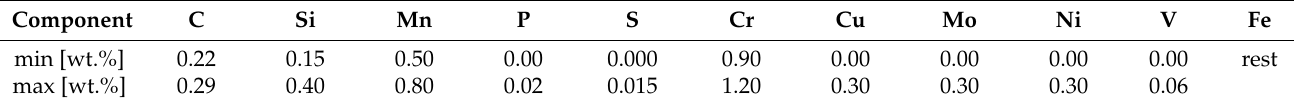
Table 1. Chemical composition of EA4T steel, according to